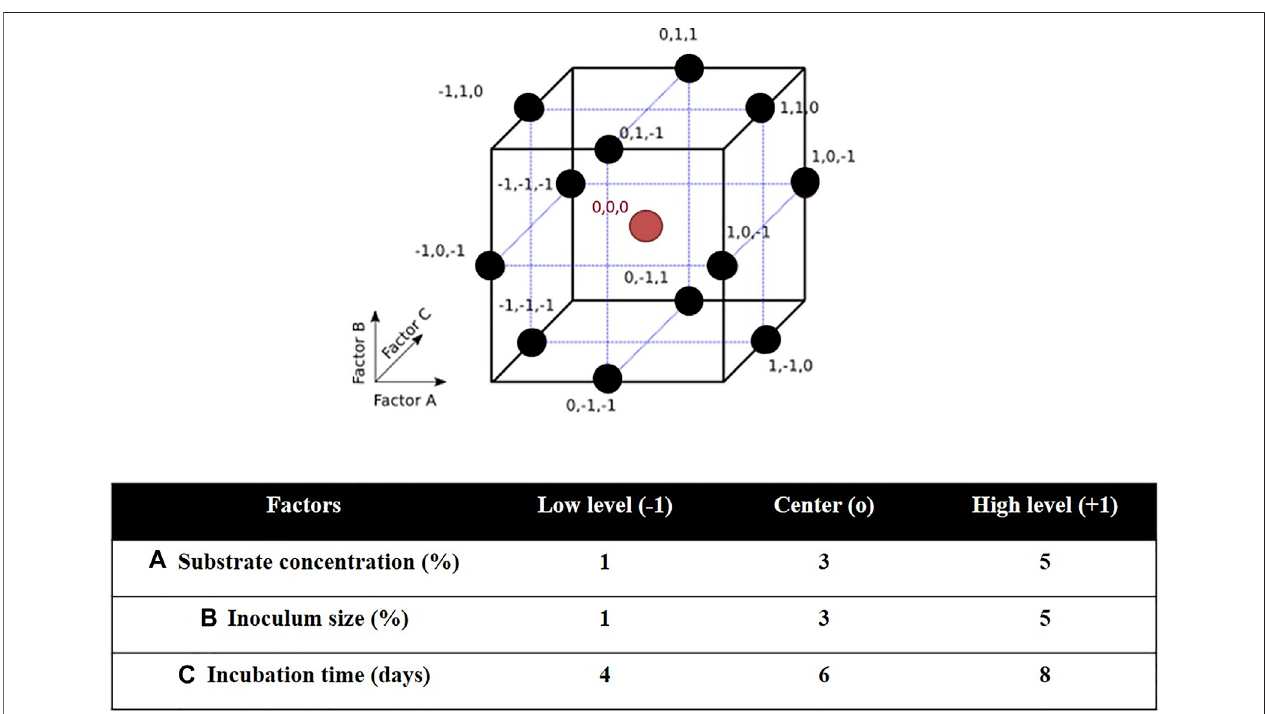
FIGURE 1 | Characteristics of Box – Behnken design (BBD): BBD space for three factors and BBD experimental domain.